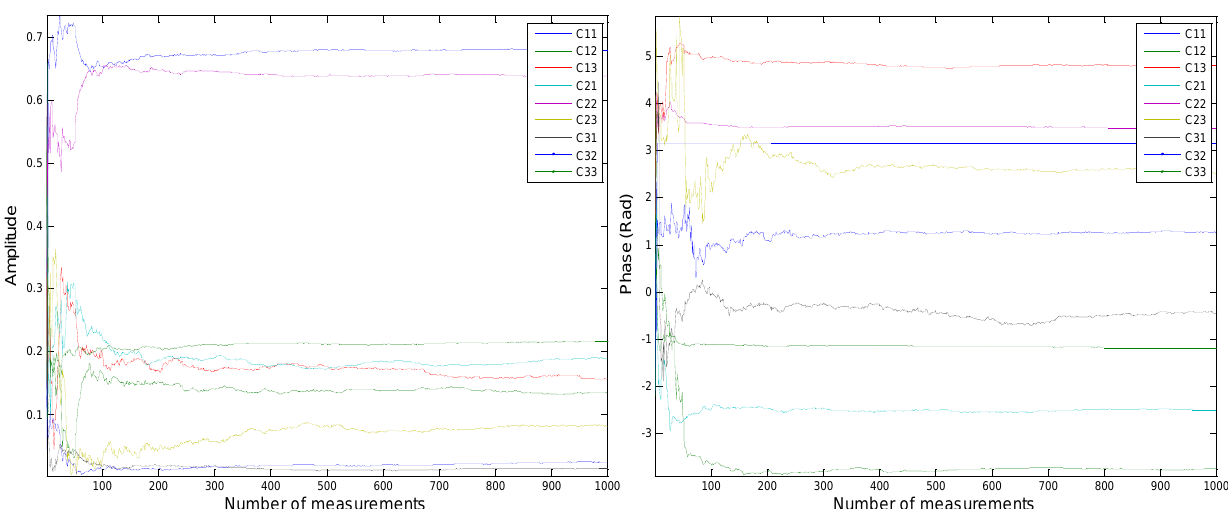
Figure 9. Amplitude and phase of the estimated calibration coefficients.